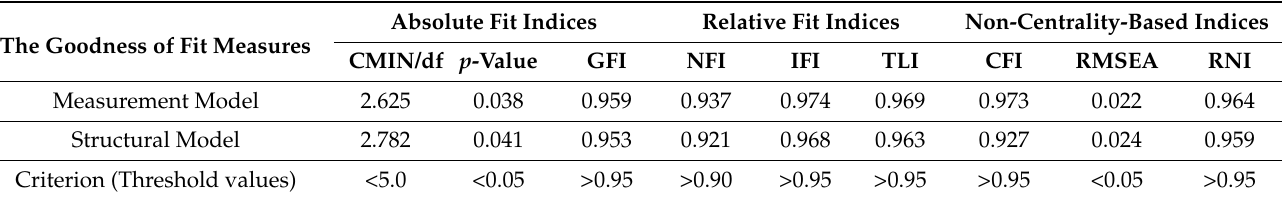
Table 2. Results of the suitability of the final SEM